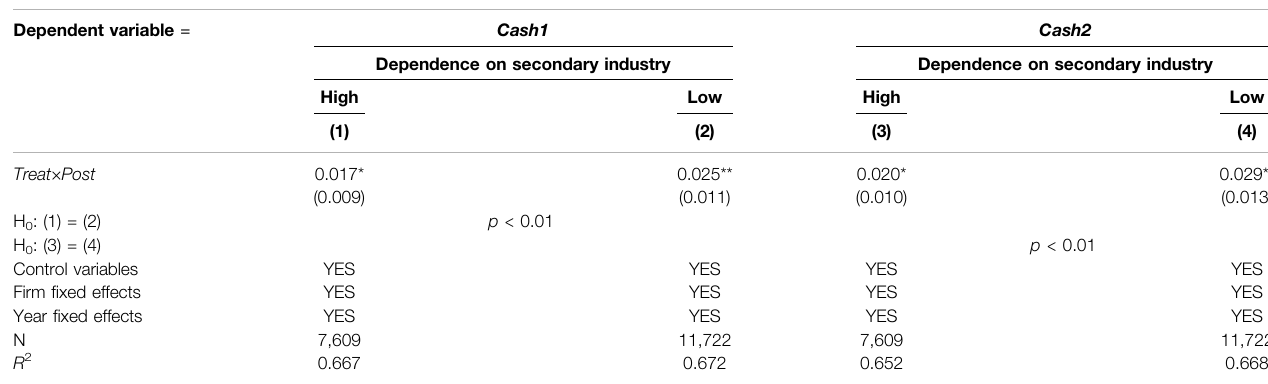
TABLE 12 | Heterogeneous Effects of environmental regulation on corporate cash